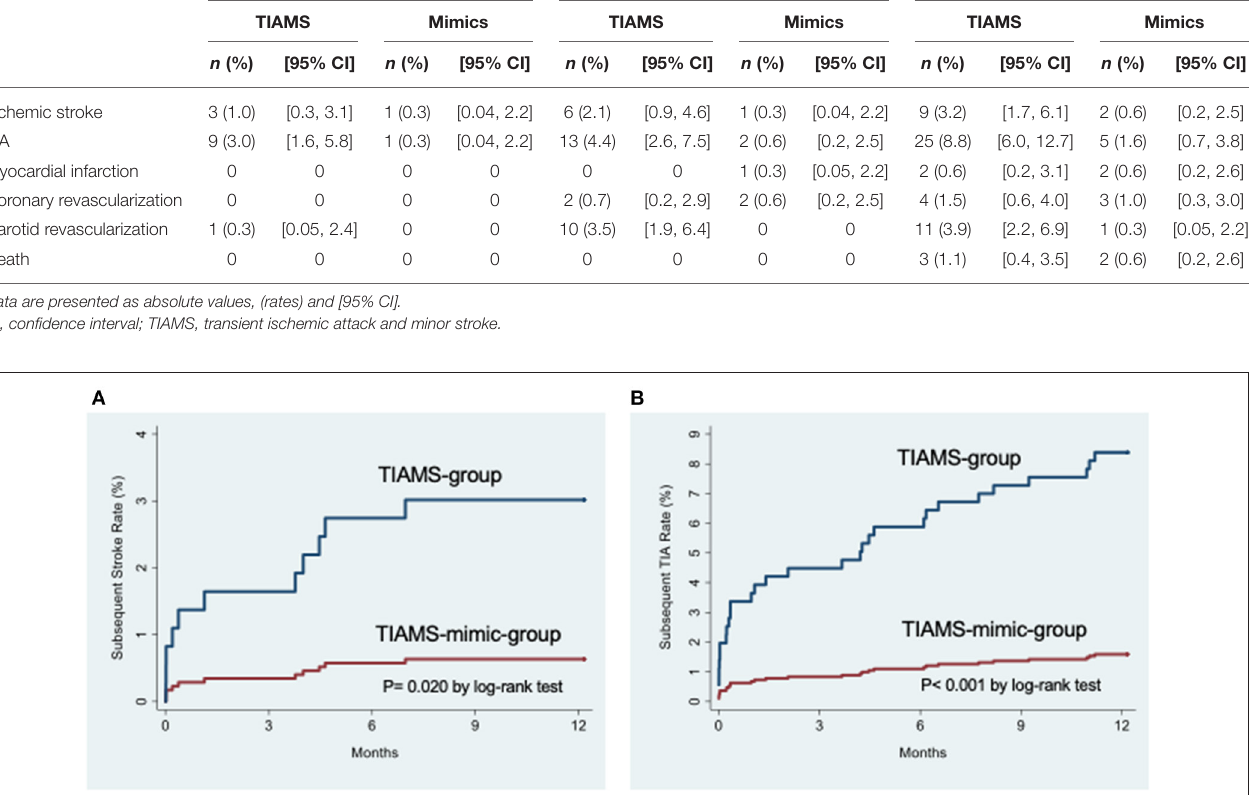
TABLE 2 | Seven days, 90 days, and 1 year event outcomes after the index event. 7 days 90 days One year TIAMS Mimics TIAMS Mimics TIAMS Mimics n (%) [95% CI] n (%) [95% CI] n (%)